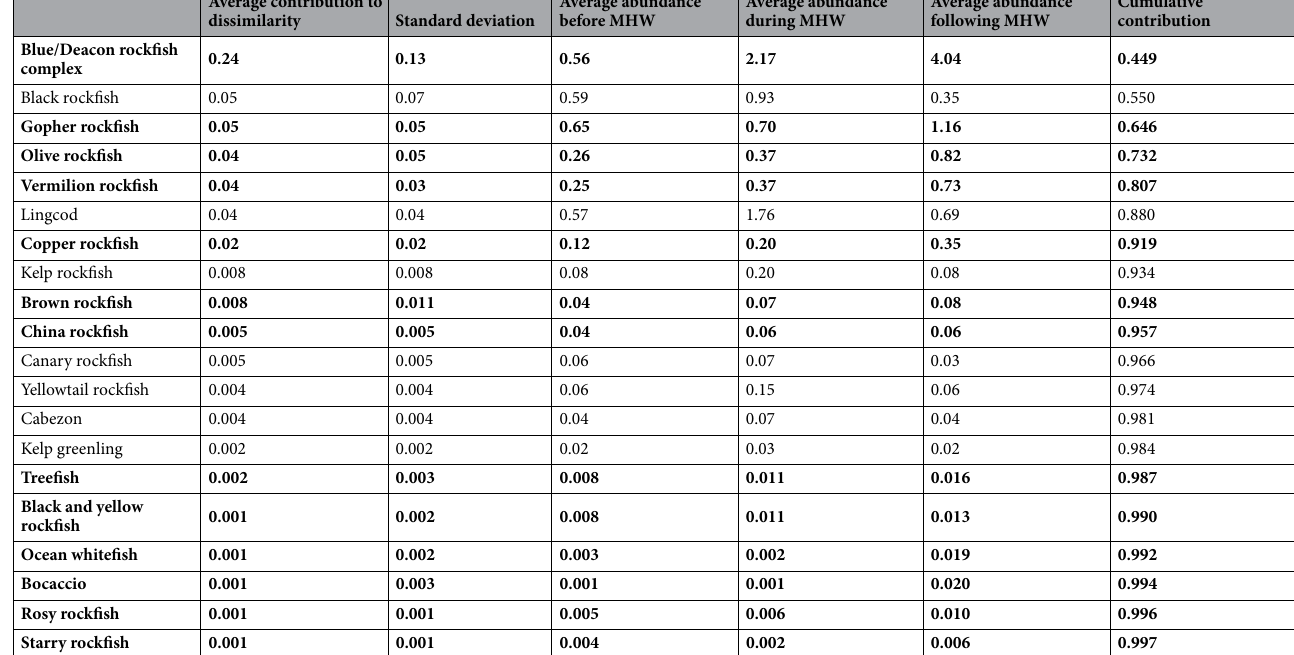
Table 1. Output of SIMPER analysis indicating the top 20 species contributing to the differences in community composition before and following the 2014–2016 MHW. Bolded species peaked in abundance following the MHW.